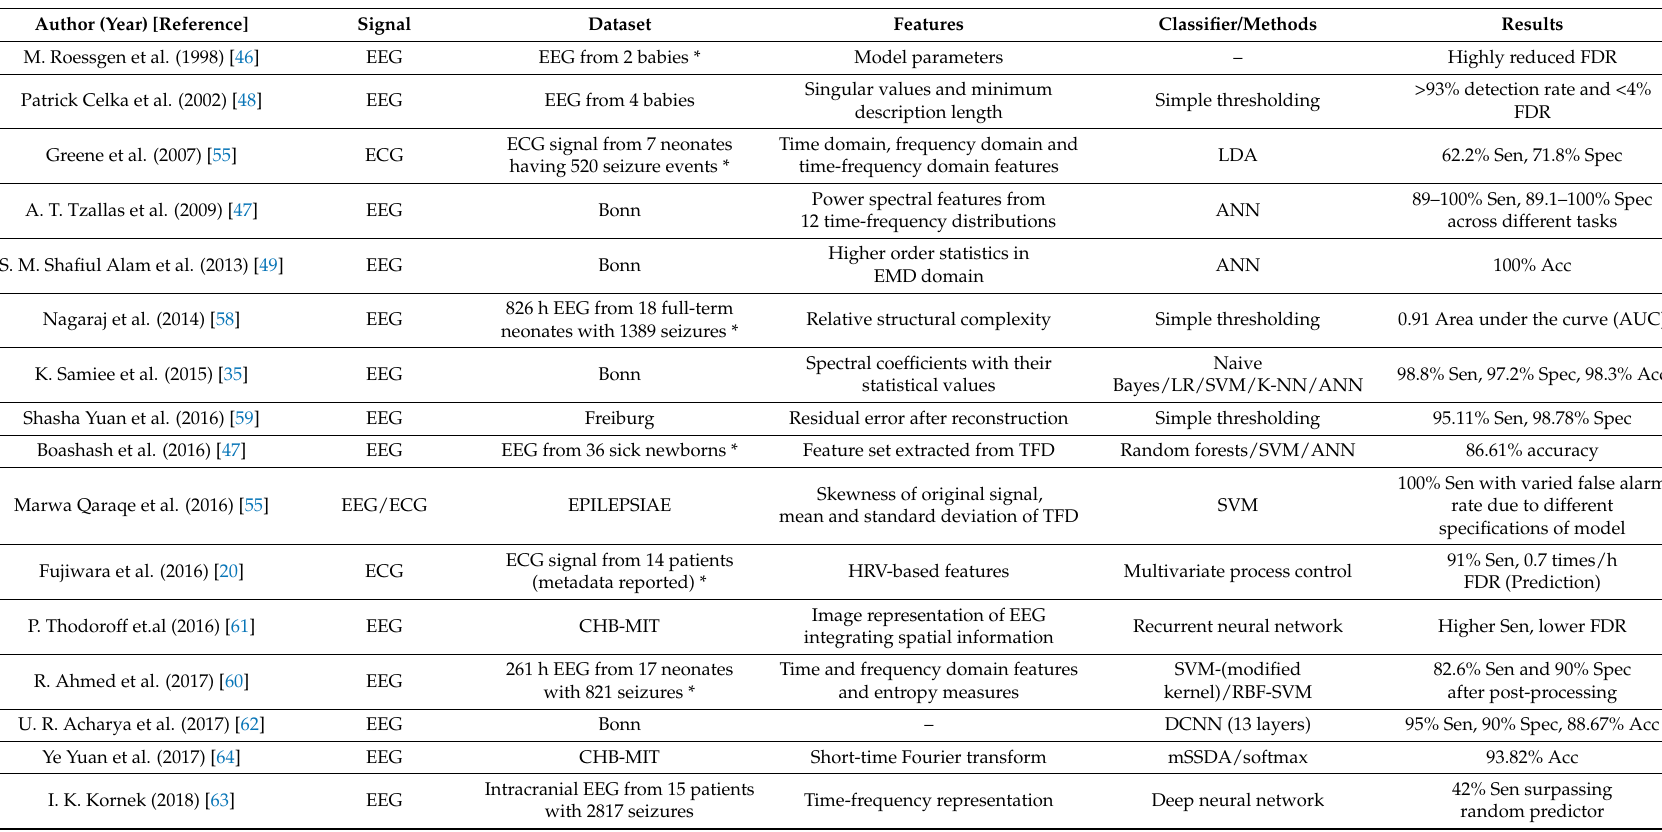
Table 1. Epileptic Seizure Monitoring using Non-stationary Signal Processing (Sen: Sensitivity. Spec: Specificity. FDR: False detection rate. “*” indicates nonpublic dataset. LDA: linear discriminative analysis. LR: logistic regression. Bonn, Freiburg, EPILEPSIAE:abbreviations of